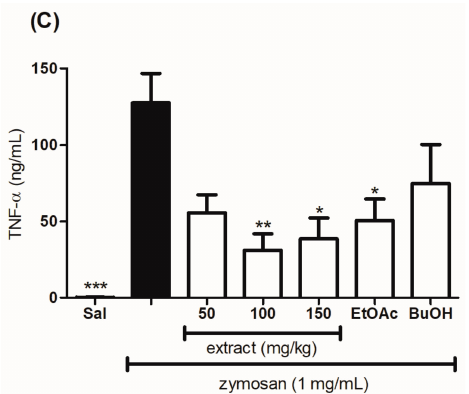
Figure 6. Evaluation of the anti-inflammatory effect of the hydroethanolic extract and the fractions of T. catharinensis leaves on the levels of myeloperoxidase and cytokines in the zymosan-induced air pouch model. Swiss mice were treated orally with a saline solution, the hydroethanolic extract at doses of 50, 100, and 150 mg/kg, the ethyl acetate (EtOAc) and n- butanol (BuOH) fractions at the dose of 50 mg/kg, and dexamethasone (2.0 mg/kg). After thirty minutes, a zymosan solution (1 mg/mL) or saline (1 mL) was injected into the animals’ air pouch. After six hours, the exudate was collected with 2 mL of saline, and the levels of myeloperoxidase ( A ), cytokines interleukin (IL)-1 β ( B ), and tumor necrosis factor TNF- α ( C ) were determined. Each column represents the mean of the values obtained from five animals, and the vertical lines indicate the standard errors of the mean (SEM). *** p < 0.001, ** p < 0.01, and * p < 0.05 compared with the zymosan group (black bar). Sal: saline (0.9 mg/mL); T. catharinensis extract (50 mg/kg); TC 100: T. catharinensis extract (100 mg/kg); TC 150: T. catharinensis extract (150 mg/kg); EtOAc: ethyl acetate fraction (50 mg/kg); BuOH: n -butanol fractions (50